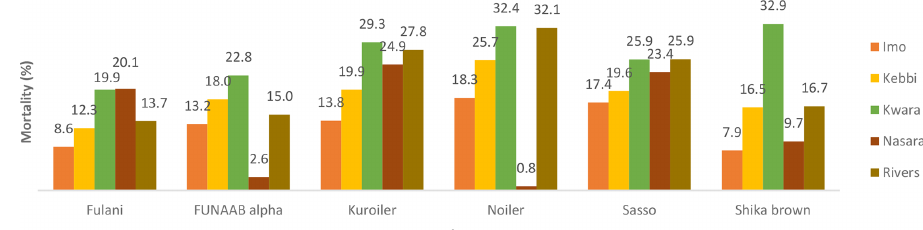
Figure 2. Actual mortality of female birds during growing phase in ACGG project zones (6–18 weeks) (2016–2017).